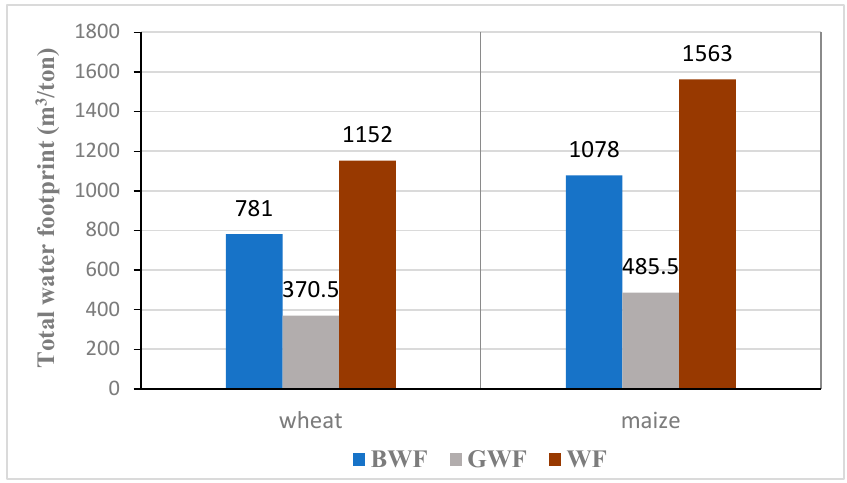
Figure 9. Mean blue, grey, and total water footprints for wheat and maize in Egypt.